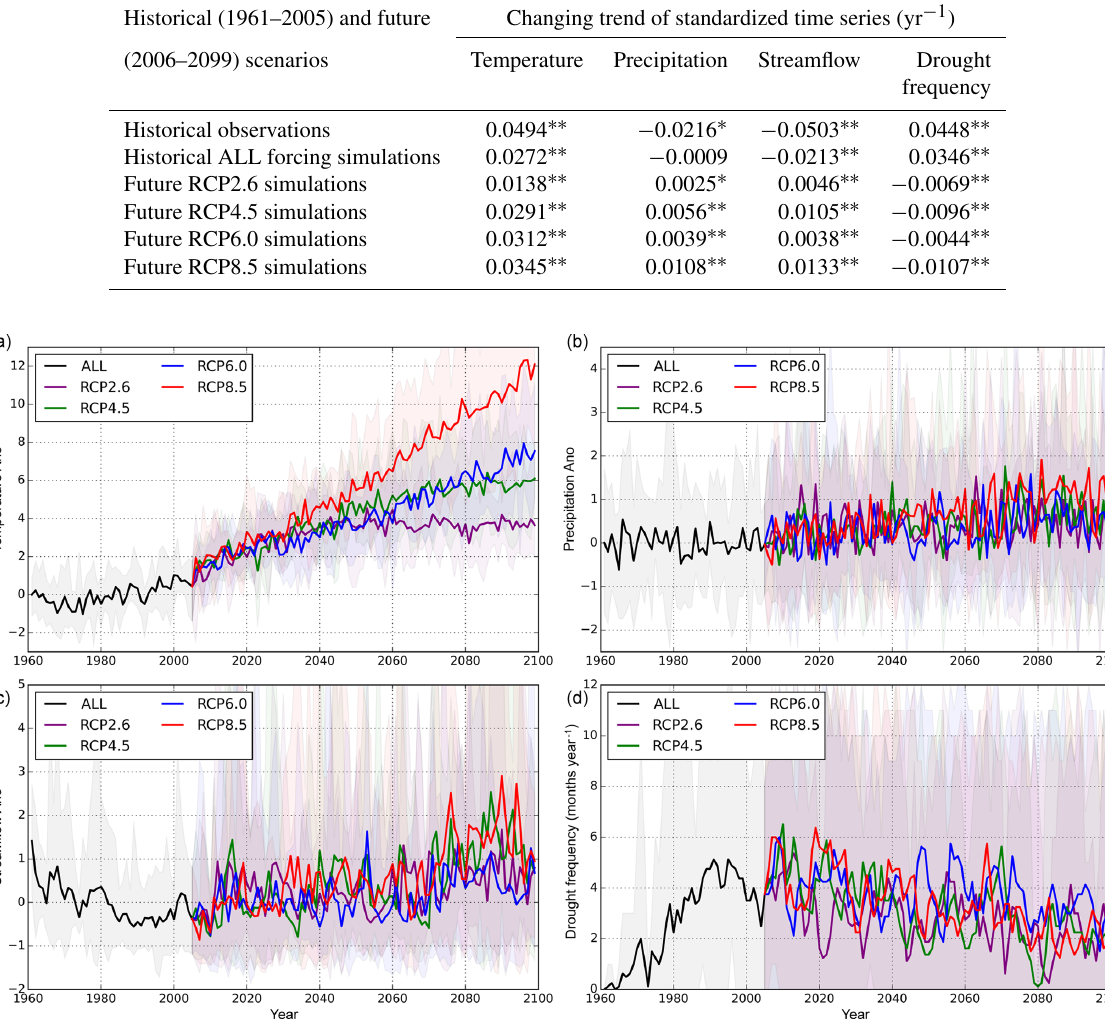
Figure 3. Historical (ALL) and future (RCP2.6, 4.5, 6.0 and 8.5) time series of standardized annual mean (a) temperature, (b) precipitation and (c) streamflow, and (d) the time series of hydrological drought frequency (drought months for each year) over the Wudinghe watershed. Shaded areas indicate the ranges between maximum and minimum values among CMIP5/CLM-GBHM model simulations. ALL represents historical simulations with both anthropogenic and natural forcings, RCP2.6, 4.5, 6.0 and 8.5 represent four representative concentration pathways from lower to higher emission